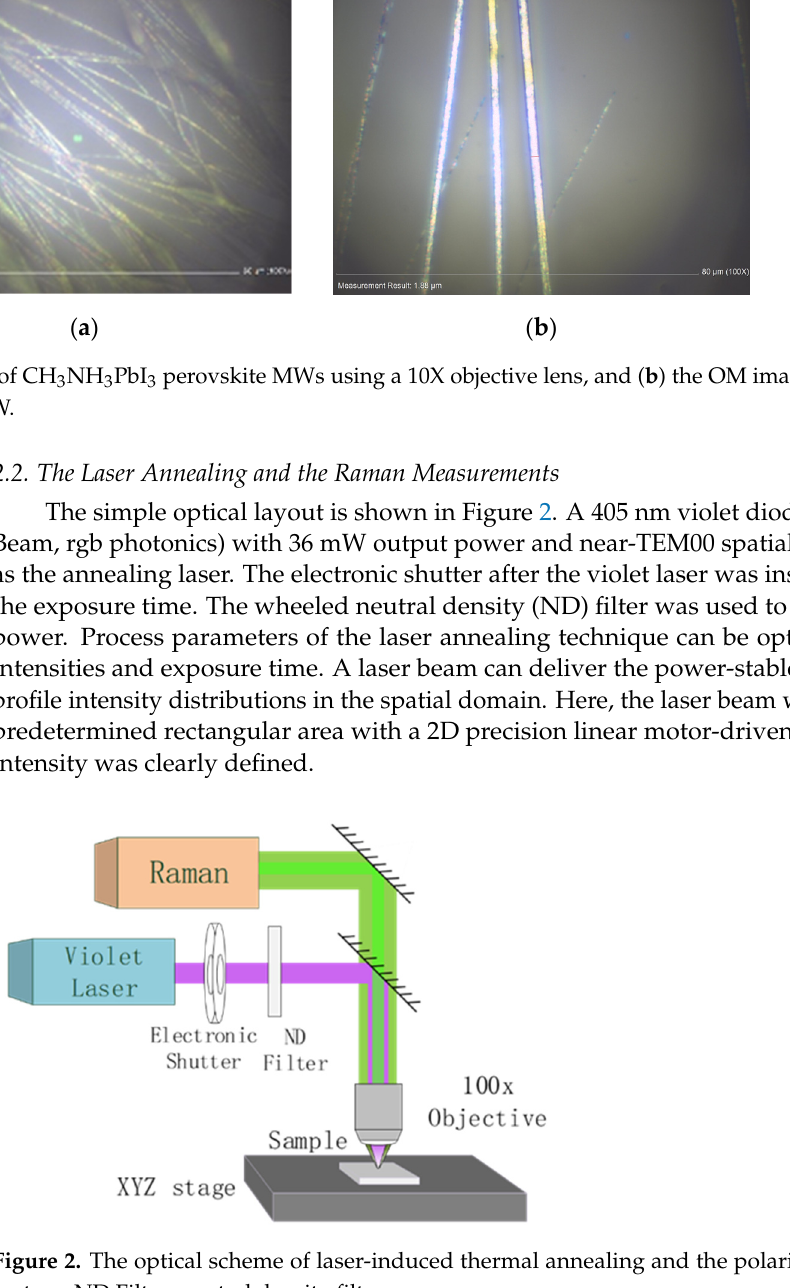
Figure 2. The optical scheme of laser-induced thermal annealing and the polarized micro Raman system. ND Filter: neutral density filter.